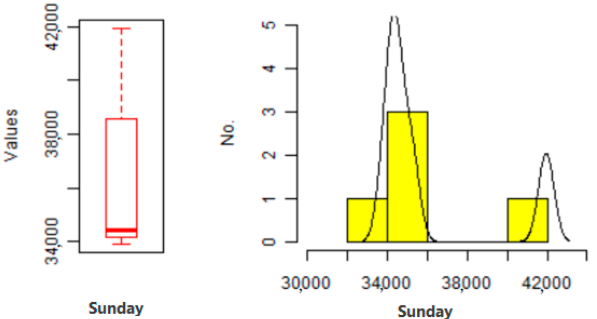
Figure 11. Before a variance of excluding the noise data on Sunday: In the graph, the vertical axis is the day of the week, and the horizontal axis is the traffic volume.